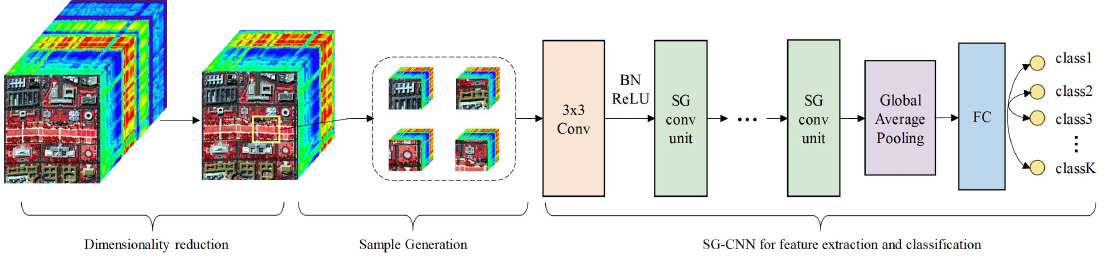
Figure 1. Shuffled group convolutional neural network (SG-CNN)-based hyperspectral imagery (HSI) classification